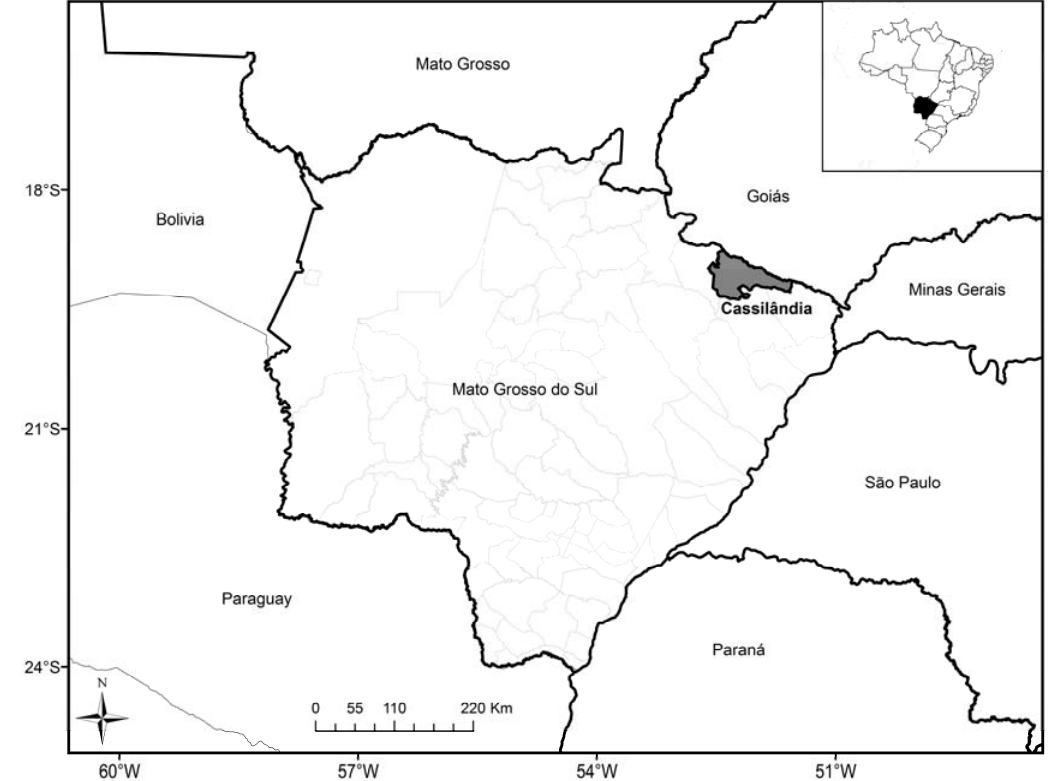
Figure 1. Map of the Mato Grosso do Sul State, Midwestern Brazil, showing the municipality of